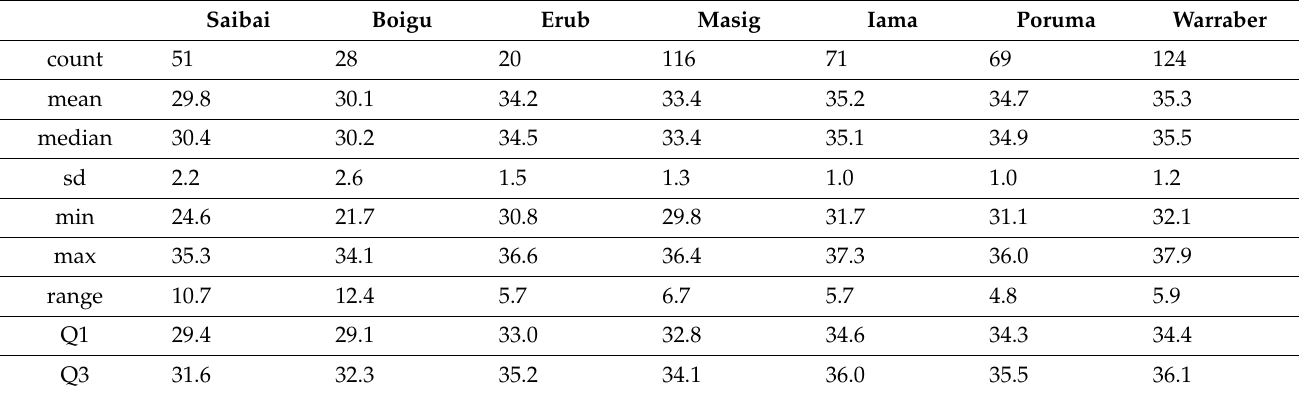
Figure A4. Time series of salinity measured at Saibai, Boigu, Erub, Masig, Iama, Poruma and Warraber Islands corrected salinity values (extracted from [22]). Table A3. Summary statistics for the surface salinity measured at the Boigu, Saibai, Erub, Masig, Iama, Poruma and Warraber Islands (Figure 1) ([22],